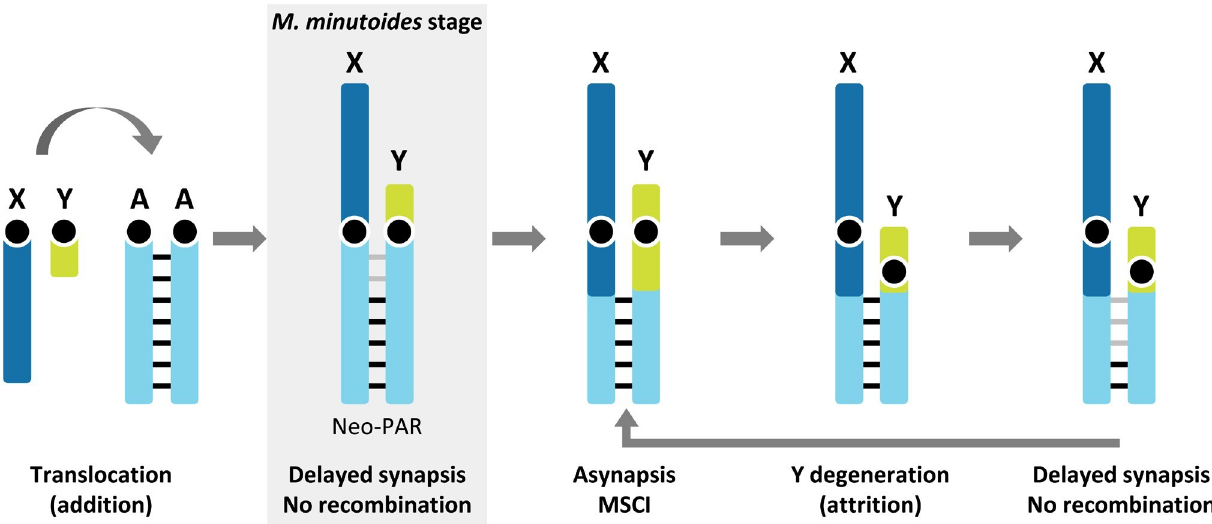
Fig 6. Schematic representation of a possible scenario for the evolution of the neo-sex chromosomes in the addition-attrition model for Mus minutoides . Before sex-autosome translocation, the autosomal pair shows standard (chromosome-wide) synapsis and recombination (black bars). Following translocation, due to structural constraints imposed by the attachment of chromosomes to the nuclear envelop and the difference in size between the X and Y, synapsis is delayed and recombination halted in the centromeric region of the neo-PAR (grey bars). These processes could consequently lead to genetic differentiation of the neo-X and neo-Y, and once meiotically essential genes have been transposed/translocated to autosomes, the region will be free to undergo large rearrangements triggering asynapsis and MSCI. This is the last nail in the coffin, causing the attrition of the Y. At this point, a new round of synapsis and recombination impairment could start over, promoting the recurrent attrition of the Y chromosome.